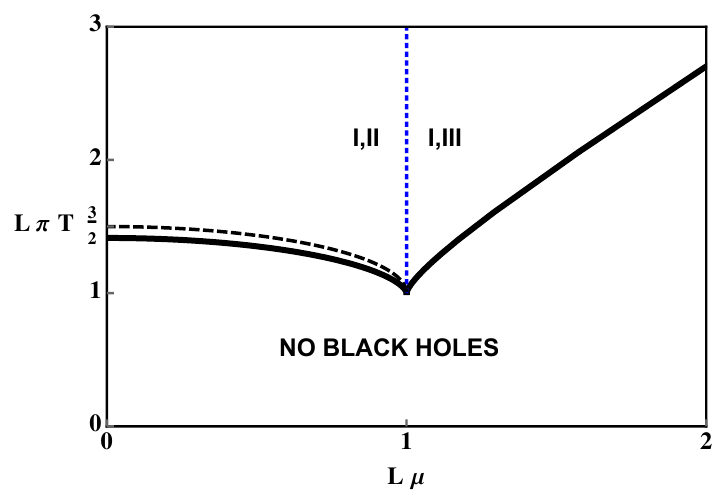
Figure 9 . Phase diagram in the grand canonical ensemble for a single nonzero chemical potential. Susceptibilities diverge at the black thick curves, and black hole solutions exist only in the region between the curves. The blue dashed line at L(cid:22) = 1 separates the unstable branches II and III . The black dashed line marks the location of the Hawking-Page transition. Notice that there is no nucleation instability in this